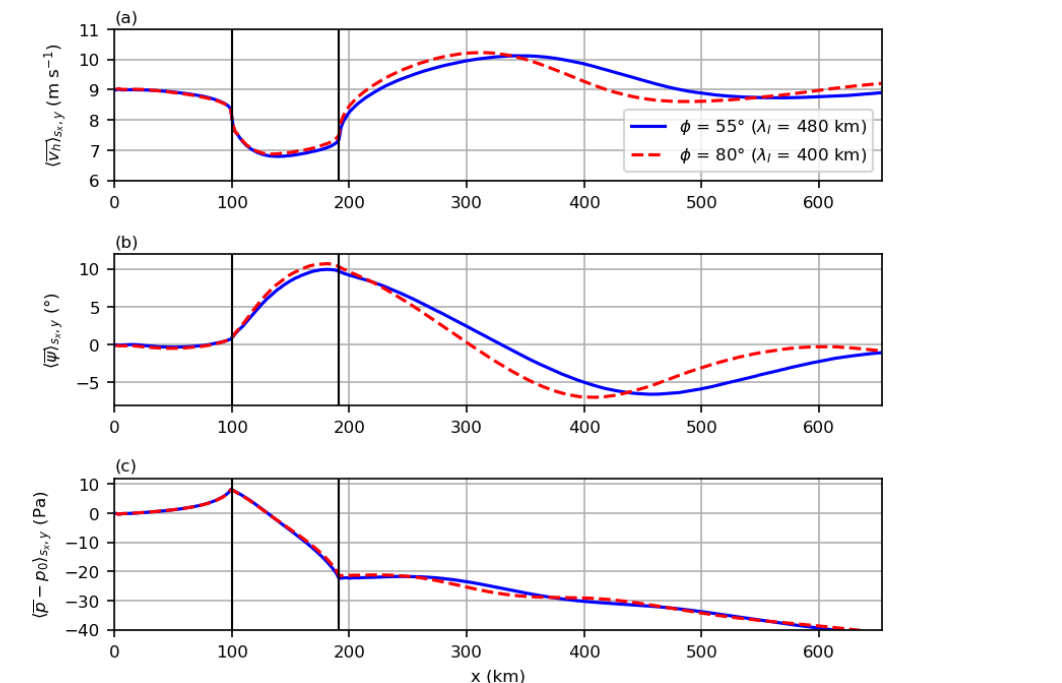
Figure B1. Horizontal wind speed, wind direction and relative perturbation pressure at hub height for the large wind farm case and a latitude of φ = 55 ◦ and φ = 80 ◦